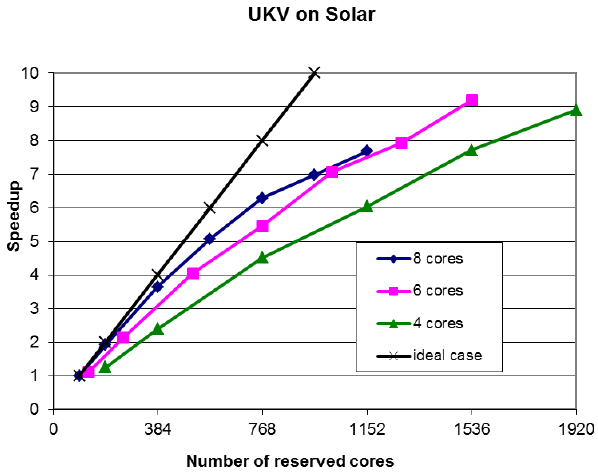
Figure 6. Speedup as a function of number of reserved cores on Solar. Speedup was calculated in relation to the elapsed time of 11488s obtained for a 96-core run on fully committed nodes.